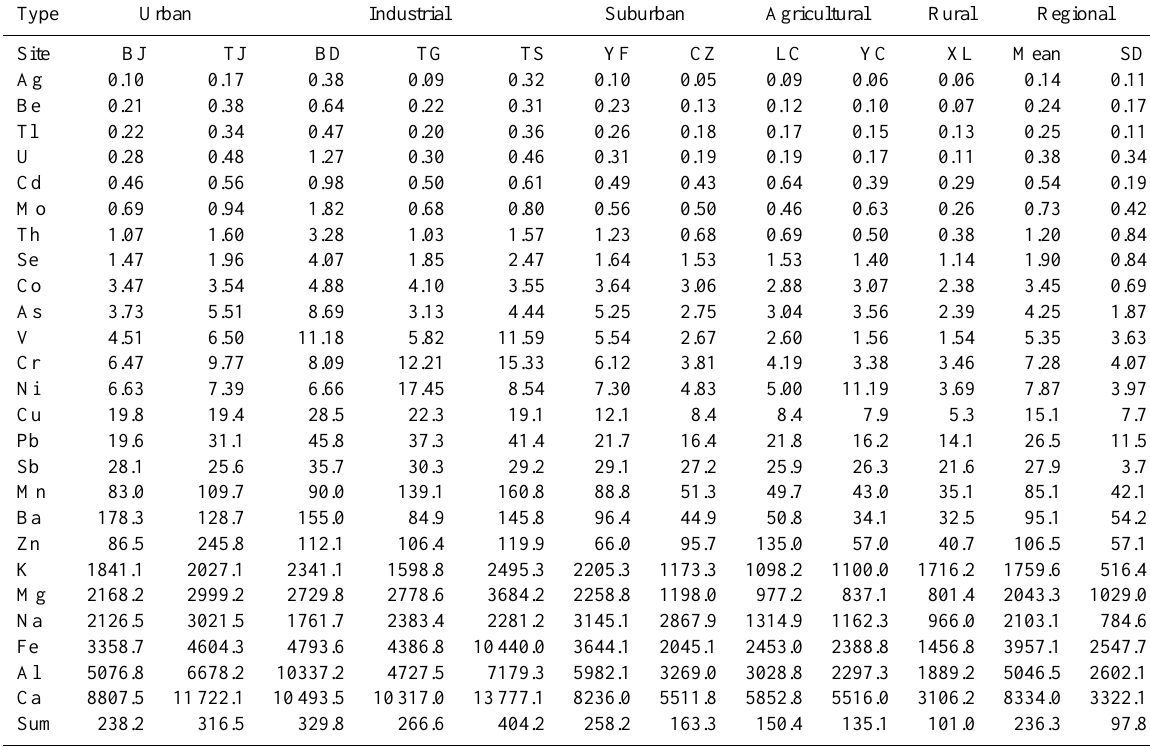
Table 4. Atmospheric total deposition flux of metals in Northern China (mgm − 2 yr − 1 ) . Type Urban Industrial Suburban Agricultural Rural Regional Site BJ TJ BD TG TS YF Ag 0.10 0.17 Be 0.21 Tl 0.22 U 0.28 Cd 0.46 0.56 Mo 0.69 0.94 Th 1.07 Se 1.47 Co 3.47 As 3.73 V Cr